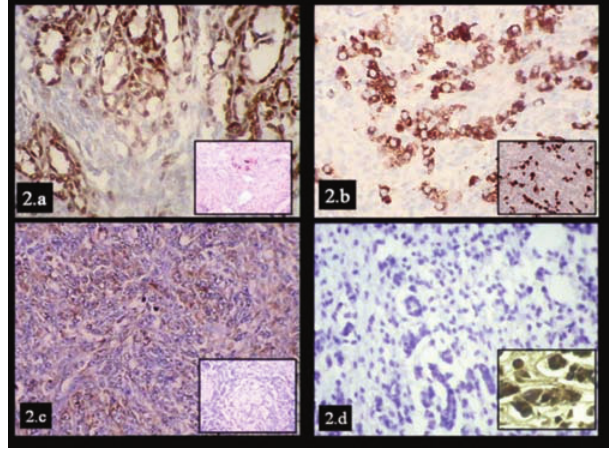
Figure 1. a) Gross: solid ovarian mass with nodular surface and cut surface show grayish white and yellowish areas; b) spindle cells admixed with plump cells with pale cytoplasm lacking reinke crystalloids and (Hematoxylin & Eosin, 400×); c) large, pulmp polygonal cells with pale cytoplasm lacking reinke crystal- loids (Hematoxylin & Eosin, 1000×); d) sertoliform cells of inter- mediate differentiation with cords, micro and macrotubules of sertoliform cells (inset) (Hematoxylin & Eosin, 400×).